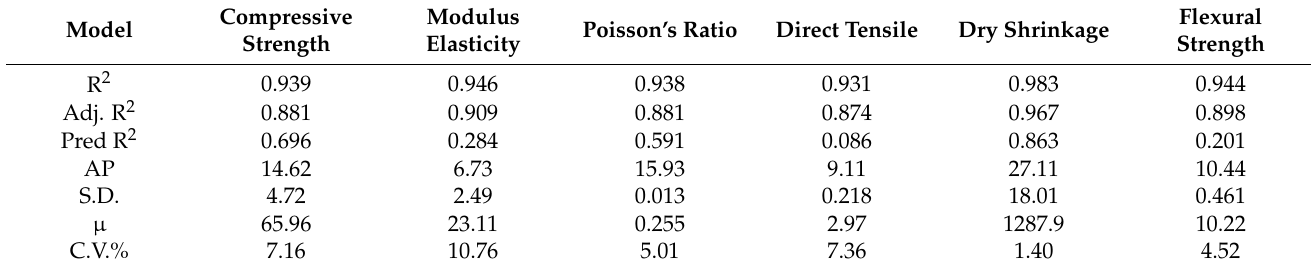
Table 7. Model validation.